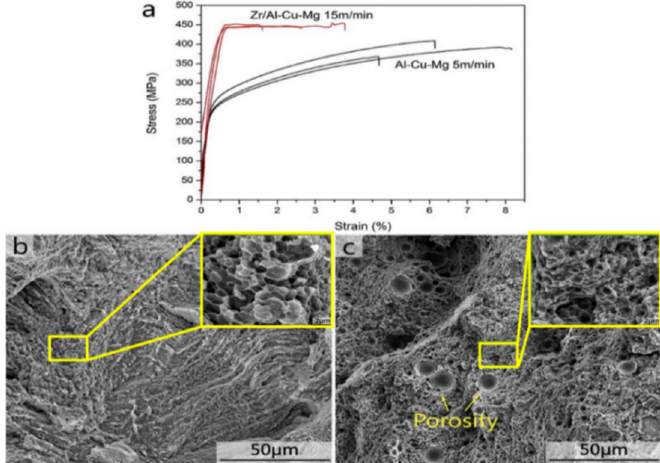
Figure 54. ( a ) Stress-Strain curves of the Al-Cu-Mg and Zr/Al-Cu-Mg samples fabricated at different scanning speeds. SEM images showing typical morphologies of the fracture surfaces of the Al-Cu-Mg sample fabricated at a scanning speed of 5 m/min ( b ) and for a Zr/Al-Cu-Mg sample fabricated at a scanning speed of 15 m/min ( c ), respectively. The insets show magnified images of the areas enclosed in yellow squares [190]. Copyright 2017. Adapted with permission from Elsevier Science Ltd.